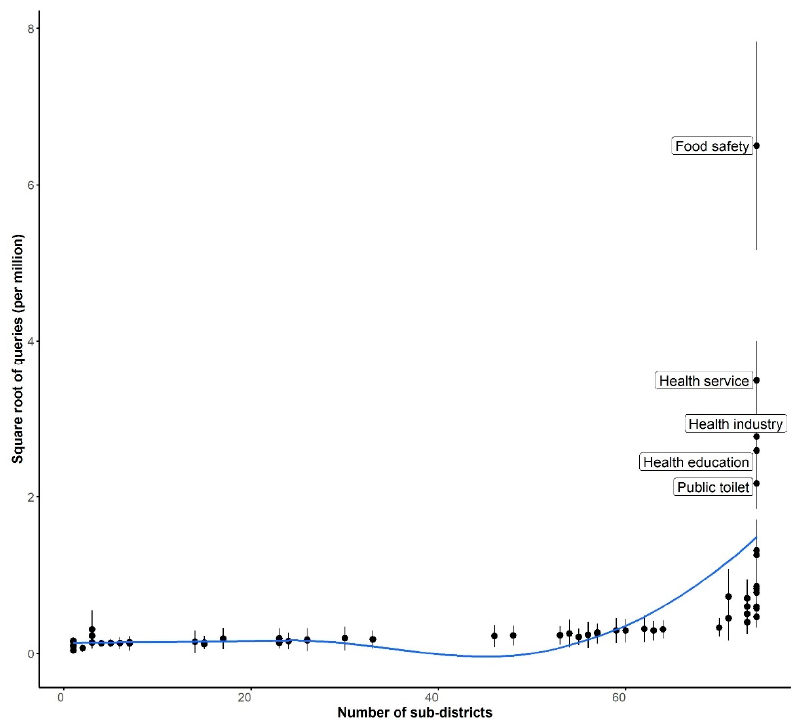
Figure 3. The numbers of search queries on each keyword in the subdistricts plotted against the number of subdistricts where search queries on the keyword were made. The dots represent the mean value, and the length of whiskers indicates the variations among the subdistricts. The top five keywords are labeled.